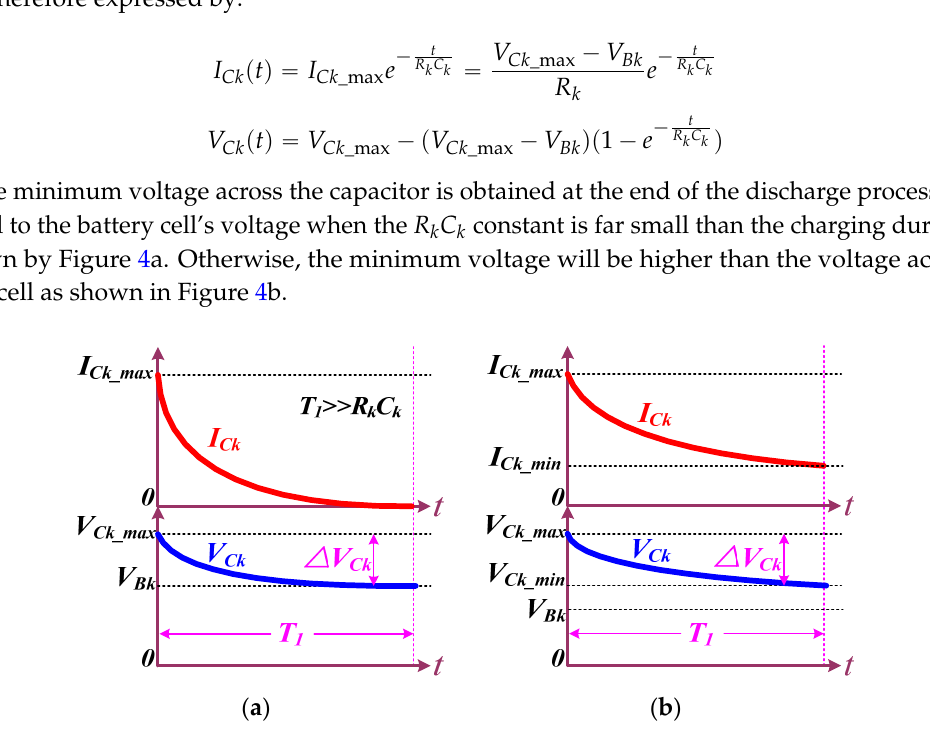
Figure 4. Capacitor current and voltage waveforms during the discharging process: ( a ) T 1 is far larger than R k C k ; ( b ) T 1 is not far larger than R k C k .